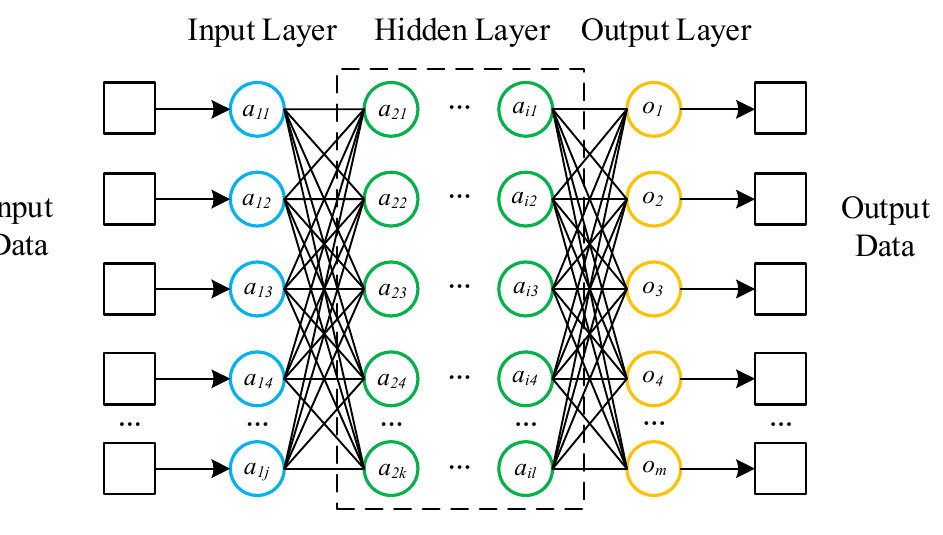
Figure 1. the basic structure of DNN. Figure 1. The basic structure of